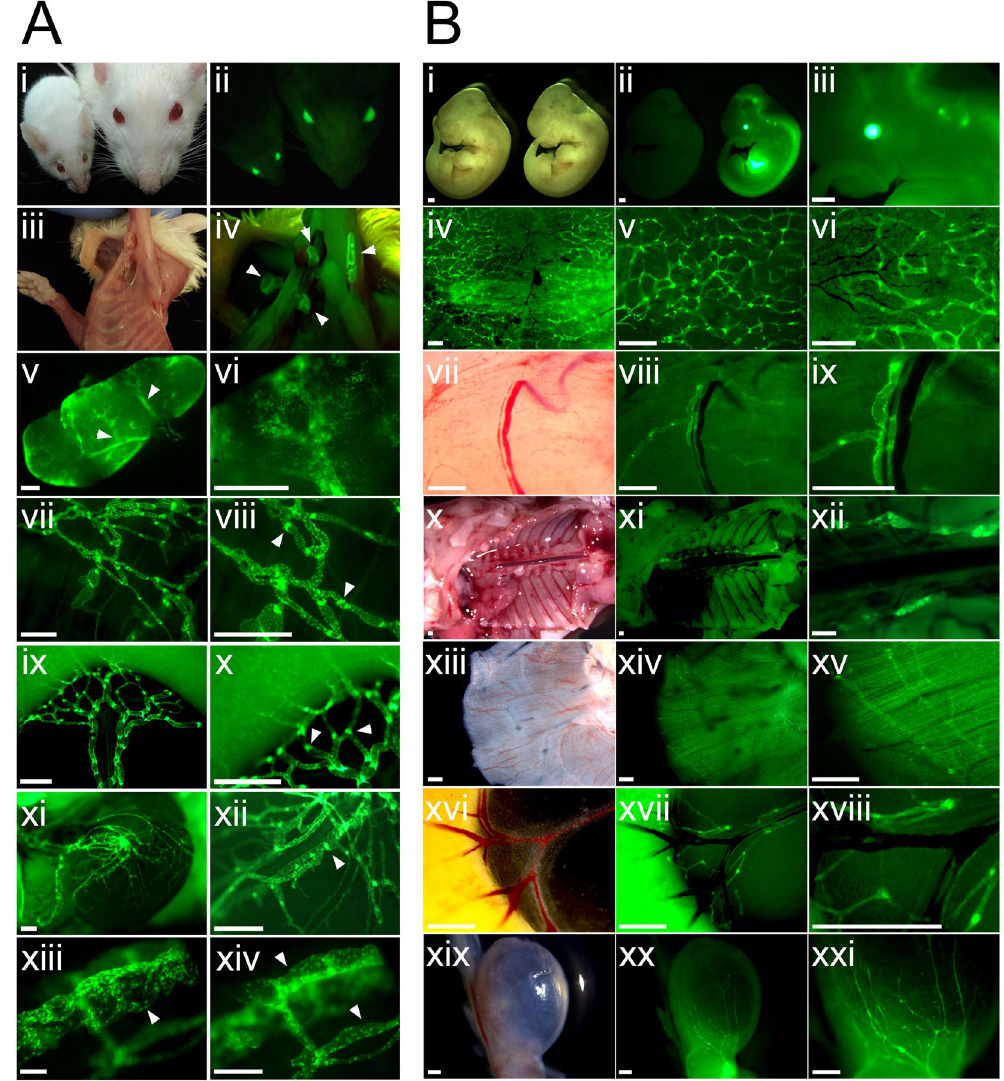
Figure 1. Characterization of the reporter expression in lymphatic vessels of Prox1-EGFP rat. ( A ) EGFP expression patterns in adults: (i,ii) Bright light and fluorescence headshots of Prox1-EGFP mouse (left) and Prox1-EGFP rat (right) highlight the size difference between the two rodents and the strong reporter expression in their lenses. (iii–iv) Cervical and axillary lymph nodes (arrowheads), which are difficult to locate under bright light without a contrasting dye, could be easily identifiable under fluorescence in Prox1-EGFP rats. (v–vi) Fluorescent images showing lymphatic vessels in the capsular and subcapsular area of an adult lymph node. (vii–xvi) Lymphatic vessels and their luminal valves (arrowheads) are clearly visible in the bladder (vii–viii), mesentery (ix–x), and testicle (xi–xii). Schlemm’s canal (arrowhead, xiii) and limbal lymphatic vessels (arrowhead, xiv) of the same eye imaged at different focuses show strong EGFP expression. Scale bars: 500 µ m (v–xii), 100 µ m (xiii–xiv). ( B ) EGFP expression patterns in embryos: (i–iii) Compared to wild type embryo (left), Prox1-EGFP rat embryo (right) shows a strong EGFP expression in the lens, central nervous system, and liver. (iv–vi) Dermal capillary lymphatic network could be easily visualized in the back skin of embryo (E17.5). Panels (v) and (vi) are enlarged images of (iv). (vii–xxi) Bright field and fluorescence images showing lymphatic vessels in the subcutaneous area (vii–ix), thoracic cavity (x–xii), diaphragm (xiii–xv), mesentery (xvi-xviii), and bladder (xix–xxi). Scale bars: 500 µ